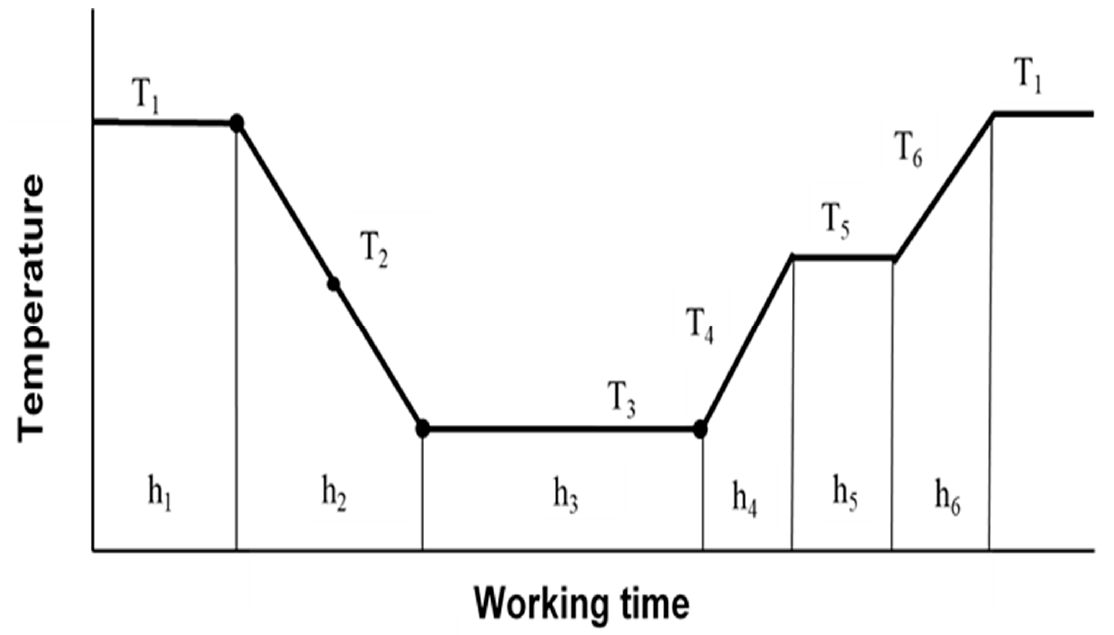
Figure 9. Change in ambient temperature during the operation of the electric machine.